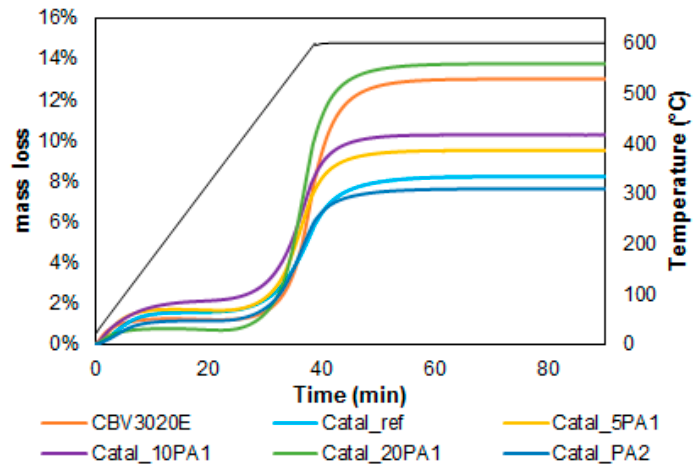
Figure 6. Percentage of mass lost during the increase of the temperature determined by TGA under air.